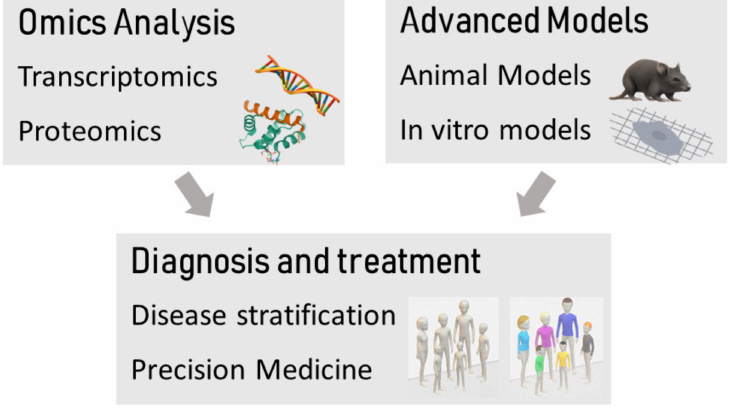
Figure 1. Combining omics technologies with advanced models can support a precision medicine approach, leading to the development of novel